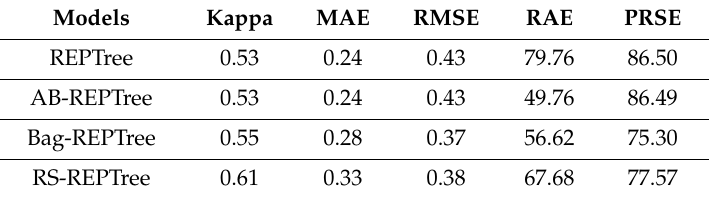
Table 5. Evaluation of gully erosion susceptibility models using error